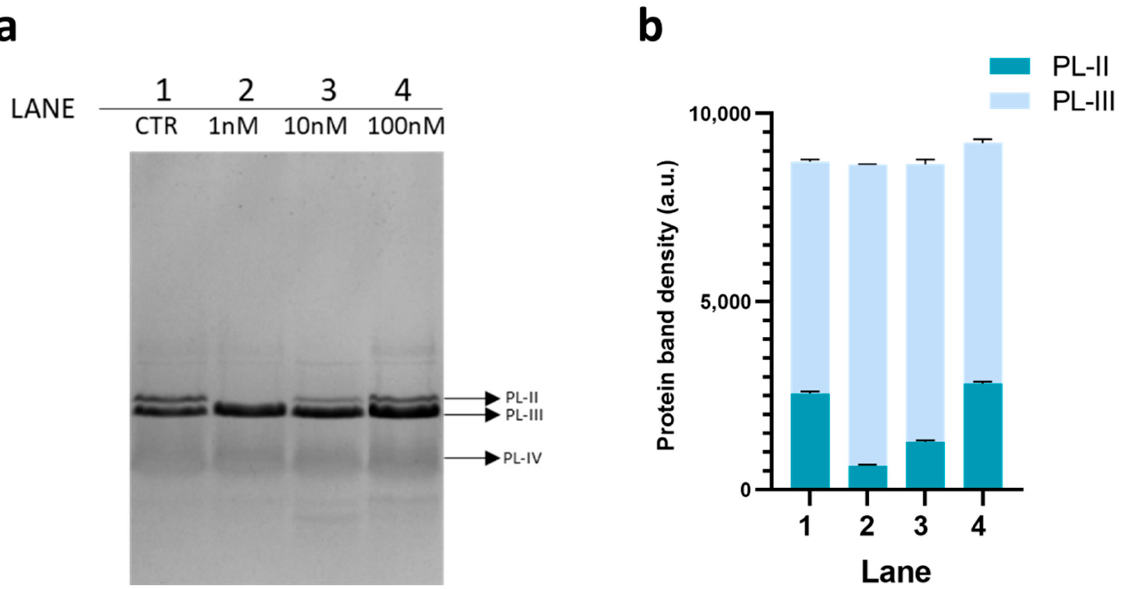
Figure 2. SDS-PAGE (panel ( a )) and densitometric bands analyses (panel ( b )) of PLs extracted from mussels. Lane (1) PLs extracted from unexposed mussels (CTR); Lane (2–4) PLs extracted from mussels exposed to 1, 10 and 100 nM chromium (VI), respectively. CTR = unexposed